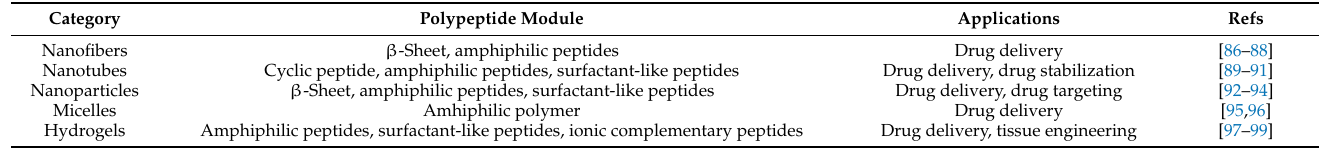
Table 2. Some nanostructures of self-assembled polypeptides and their